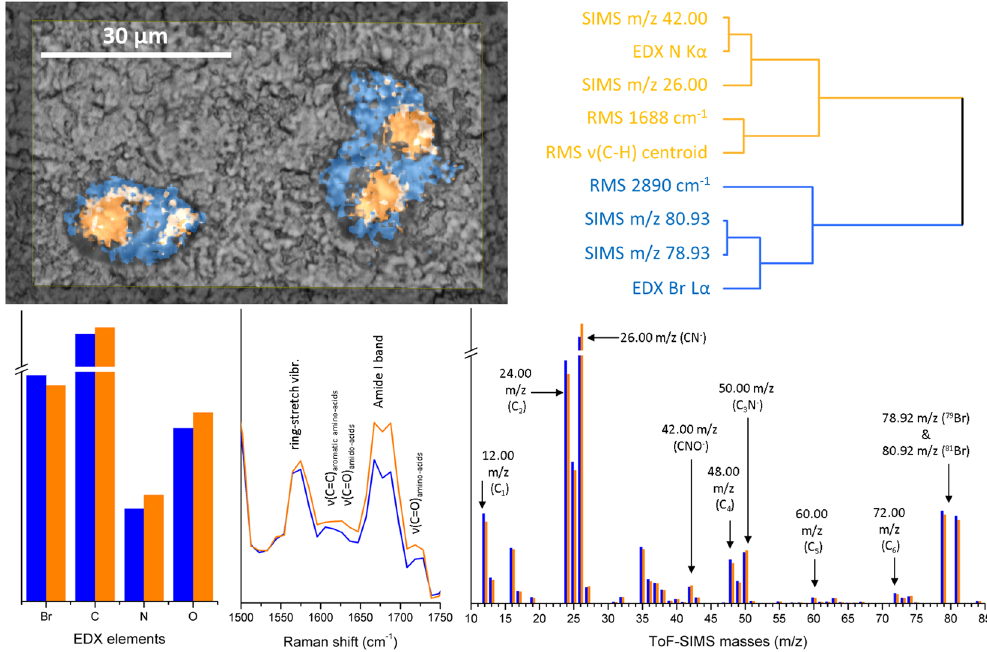
Figure 3. Superposition of a light-microscopic image of two tumour cells and results from the HCA of the PCA loadings and extracted cluster spectra from k-means clustering of the MSHSI